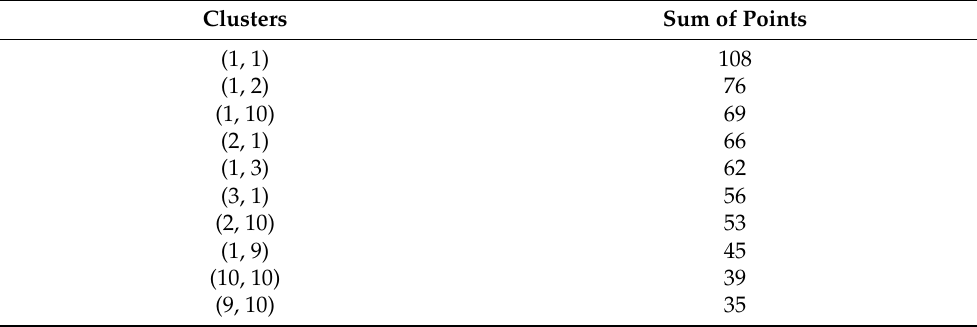
Table 30. Overall ranking of clusters (first ten